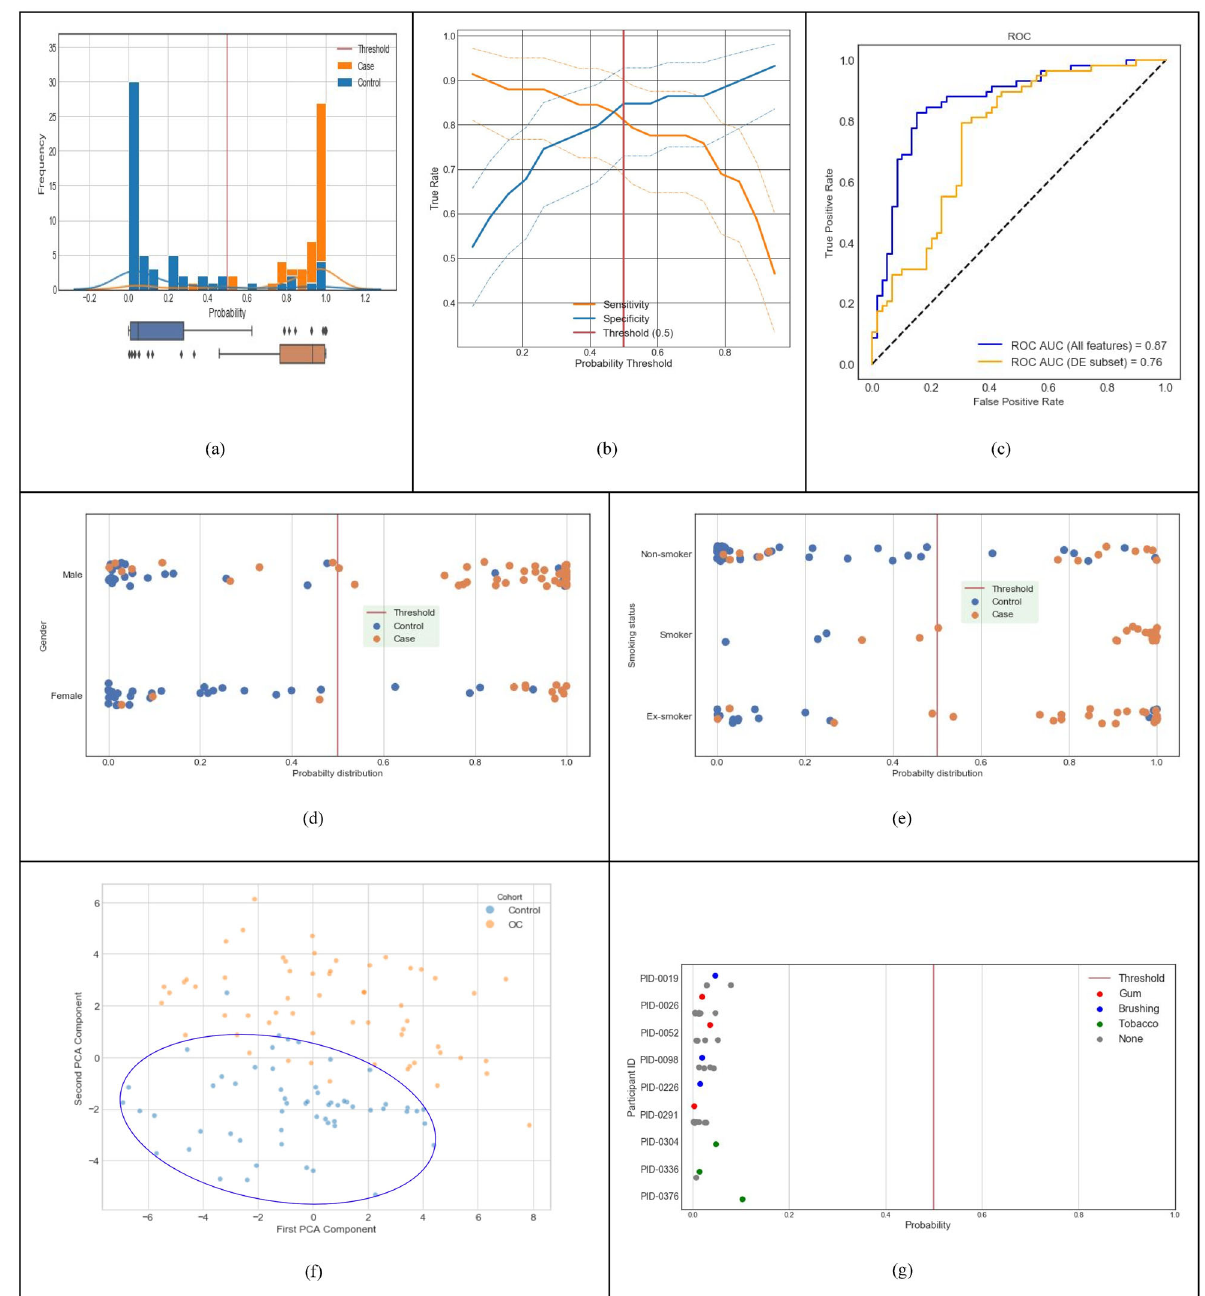
Fig. 2 Predictive performance of machine-learnt classi fi er trained with discovery dataset (Cohort A in Table 1). a Distribution of classi fi er output probabilities across the sample set. b Sensitivity & speci fi city tradeoff with 95% con fi dence interval computed using the Clopper- Pearson method; at the default decision boundary of 0.5, sensitivity is 0.81 and speci fi city is 0.85. c ROC AUC of the classi fi er using the LOOCV method is 0.87 (blue curve); using differentially expressed features only is 0.76 (orange curve). d Classi fi er probabilities separated by gender. e Classi fi er probabilities separated by smoking status. f PCA analysis using top 100 features (PC1 and PC2 capture 10.2% and 6.3% of the total variation, respectively.). g Probability of cancer output from the classi fi er for control samples with and without interference from chewing gum, chewing tobacco, and brushing diversity indices, such as the shannon index or the inverse detected a wide range of unique active microbes (1587 active simpson diversity index between cases and controls. In general, species, sample mean 438 ± StD 81) and unique active functions diversity measures both richness and evenness, and in this (4932 KEGG Orthologs or KOs, sample mean 2270 ± 314). As dataset, although there is a lower richness in active species, shown in Fig. 1a, we observed a lower richness in cases compared Pielou ’ s evenness index is not signi fi cantly different between to controls, both in terms of active species and active KOs. cases and controls ( p value = 0.72). Overall, the ecological change However, as shown in Fig. 1b, we do not see a statistically in decreasing richness in cases does not seem to be driven by a signi fi cant difference (using Mann – Whitney U (MWU) test) in